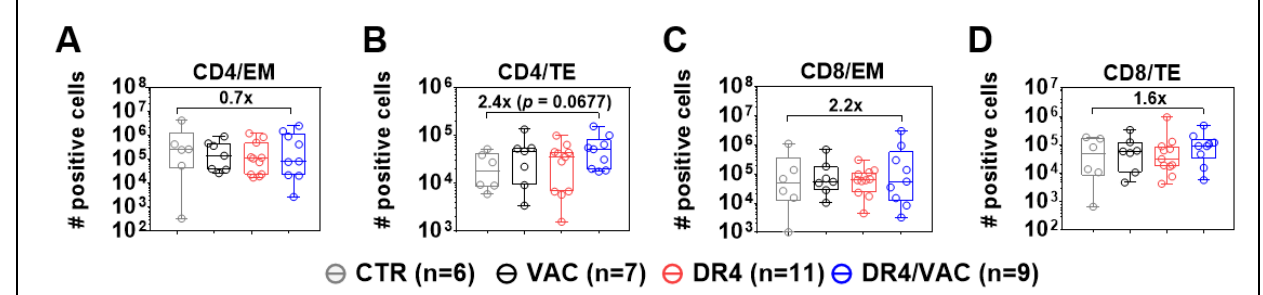
Figure 9. DR4 combined with VAC promotes CD4 + and CD8 + T cell maturation. Terminal analyses of absolute numbers (#) of positive cells identified as CD4 + effector memory (EM) ( A ); CD4 + terminal effector (TE) ( B ); CD8 + effector memory (EM) ( C ); and CD8 + terminal effector (TE) ( D ) in spleen by FACS. X-fold difference of the mean comparing the values obtained for controls and DR4/VAC mice is indicated in the plots. Data pooled from four independent experiments. Statistical analyses were performed using the Welch t -test applied to log data (unpaired).